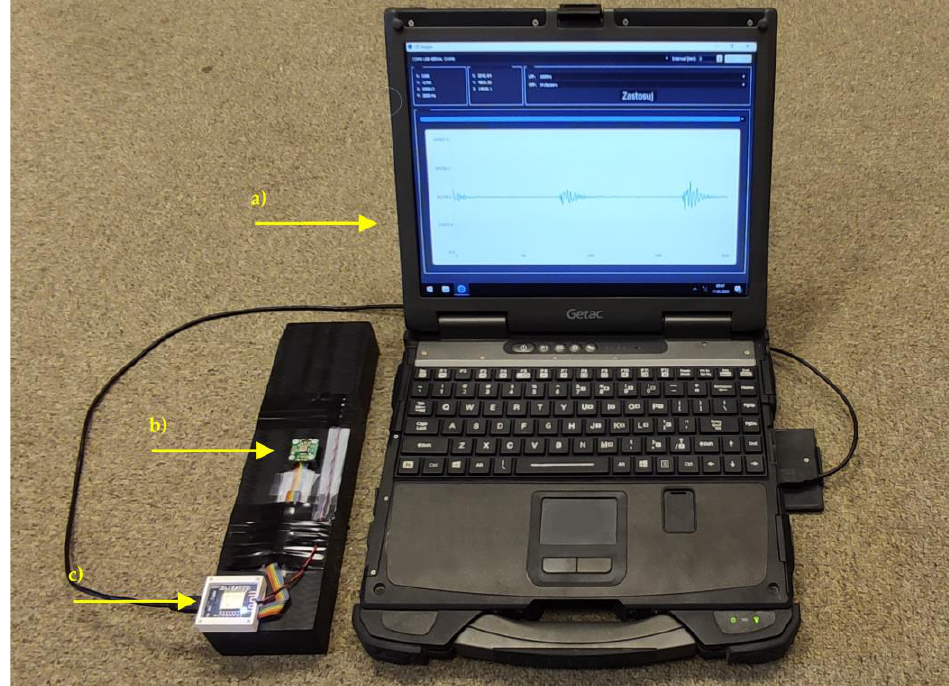
Figure 3. Components of MEMS-based acceleration measuring system: ( a ) laptop; ( b ) MEMS accelerometer; ( c ) supporting chip.